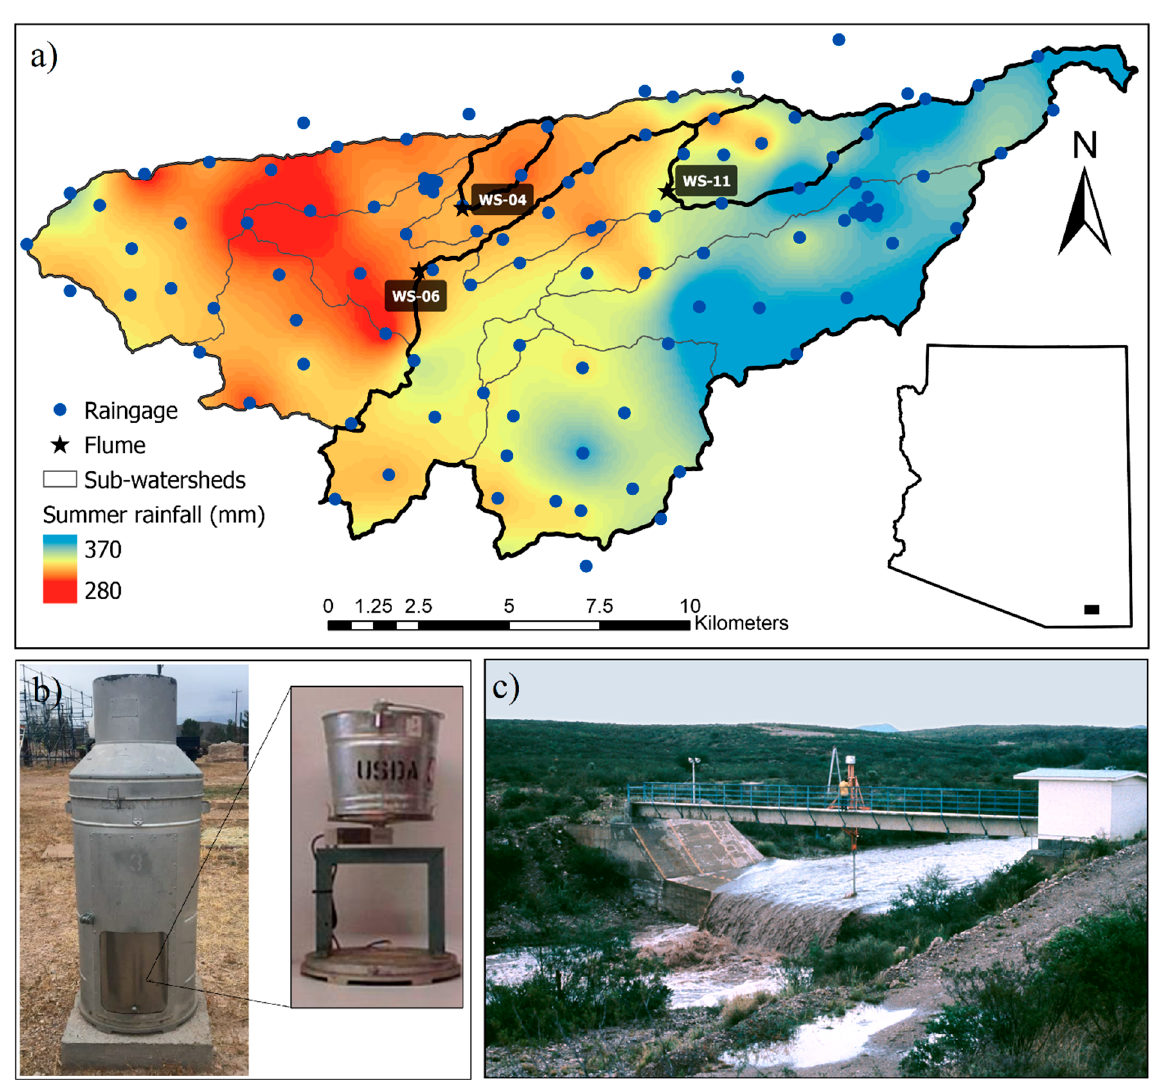
Figure 1. Illustration showing ( a ) the Walnut Gulch Experimental Watershed (WGEW) geographic location with associated sub-basins (primary (WS-04, WS-06, and W-011) delineated in bold lines and secondary delineated in thin lines), average total summer rainfall (2000–2017), and spatial distribution of 99 rain gages; ( b ) a US Department of Agriculture digital weighing rain gage typical to WGEW; and ( c ) typical flume in WGEW, example from WS-06-Flume 6.